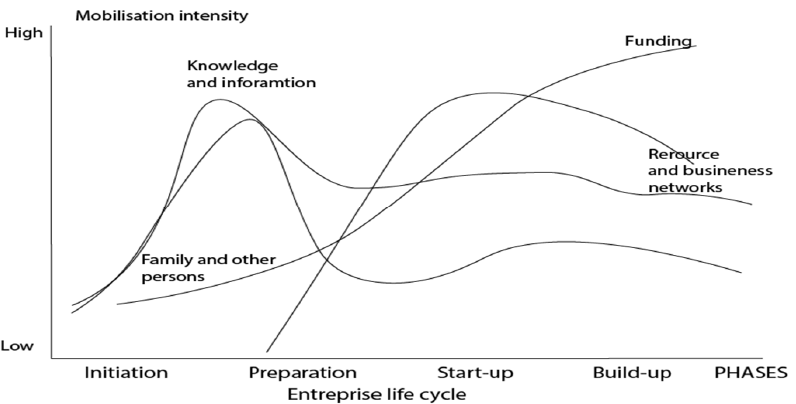
Figure 6. The social capital mobilized by each network throughout the four stages of the development process of a rural lodging.